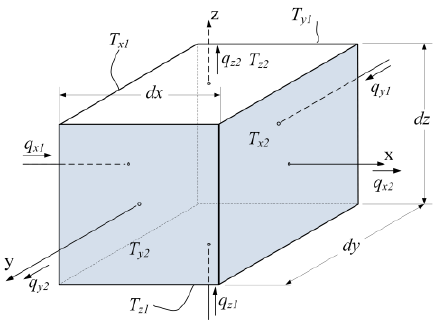
Figure. 2 An elemental volume of the solid under analysis. 143 Figure 2. An elemental volume of the solid under